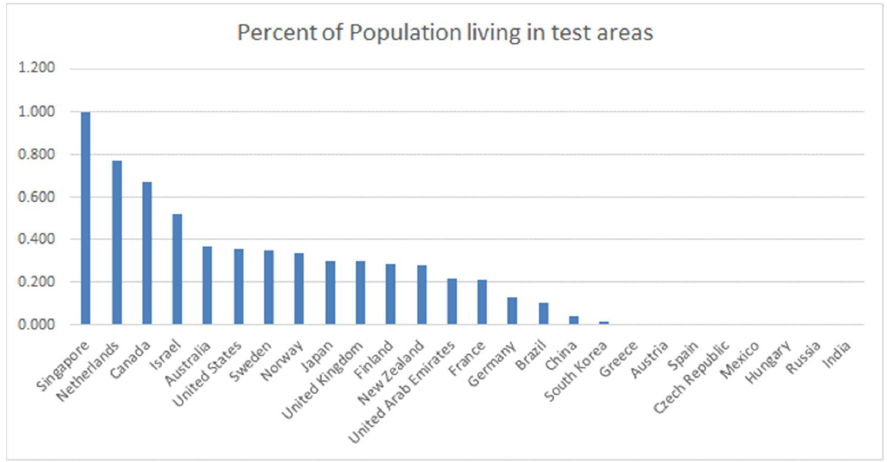
Figure 2. Greece’s AVRI listing in Pillar IV—Percent of population in test areas.